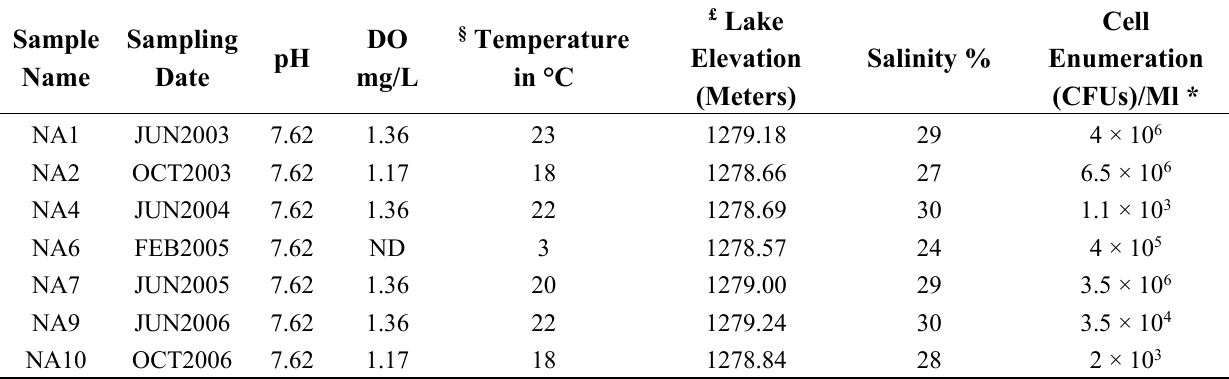
Table 1. Characterization of Great Salt Lake north arm